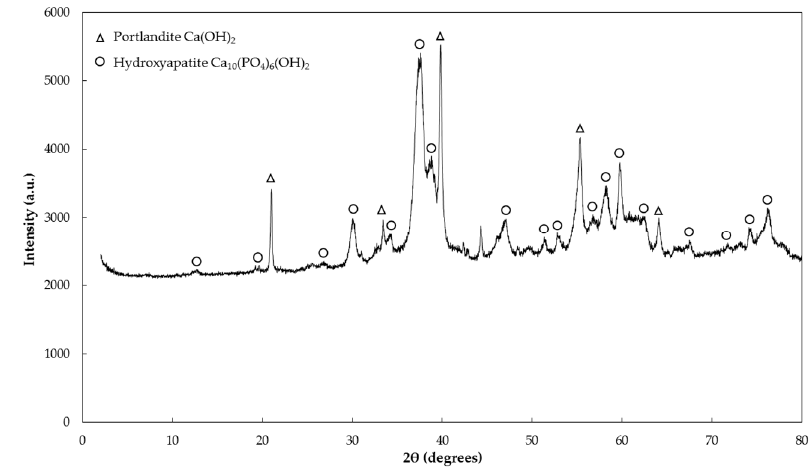
Figure 11. X-ray diffraction pattern of NaHMP solution and Ca(OH) 2 at 3 h mixing dried at 60 °C and 50 mbar.